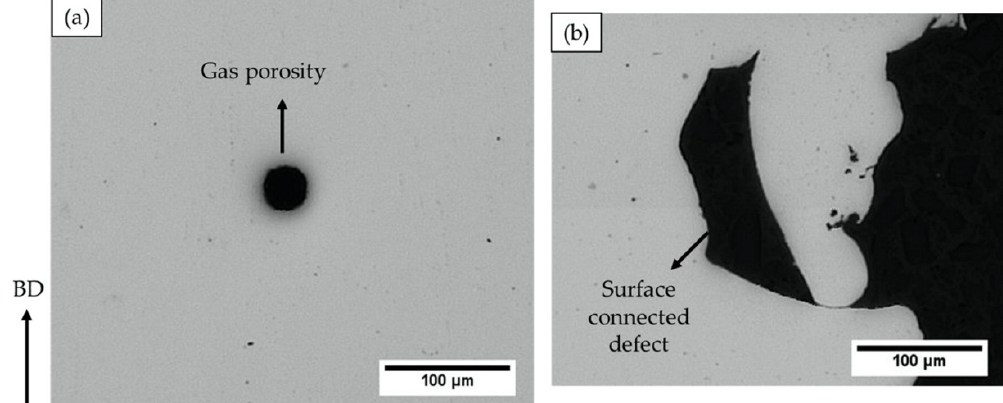
Figure 4. LOM micrographs revealing the remnant defects in the hot isostatic pressed (HIPed) EBM Alloy 718: ( a ) gas porosity and ( b ) lack of fusion. The arrow on the left indicates the build direction.